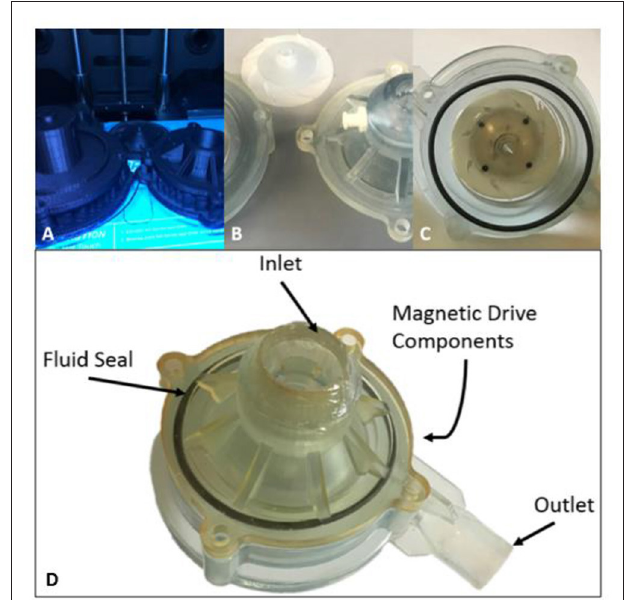
FIGURE 5 | Design Progression of Magnetically Levitated Centrifugal Pump Prototypes. (A) Initial polylactic acid (PLA) extruded pro-totypes, (B) Stereolithographic 3D printing prototypes machined for testing, (C) Final pump prototype with point and support stabilization, (D) Top inlet volute with fluid seal in place and magnetic drive components to support